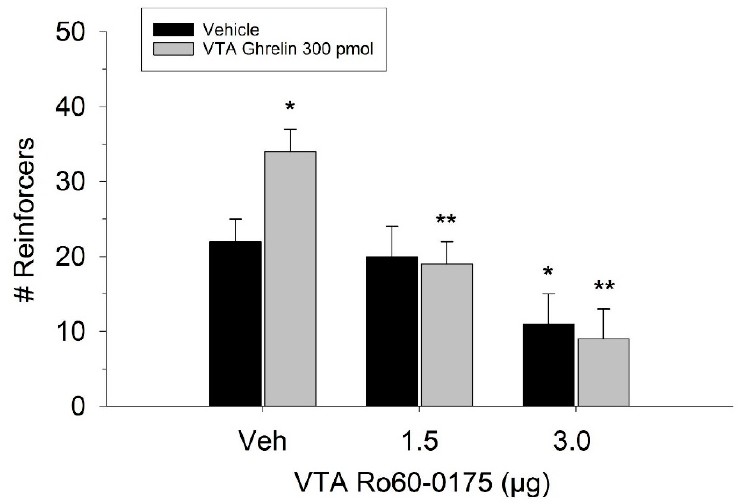
Figure 5. Effect of Ro60-0175 and ghrelin co-administration into the VTA on operant responding for food reward. Both doses of Ro60-0175 inhibited the effect of ghrelin as observed with a significant reduction in the number of reinforcers acquired compared to the ghrelin/saline treatment condition. The higher dose of Ro60-0175 was also found to suppress responding when paired with vehicle (Veh). Data are represented as mean number of reinforcers ± SEM; n = 8. * p < 0.05 compared to Veh. ** p < 0.05 compared to ghrelin co-injected with saline.